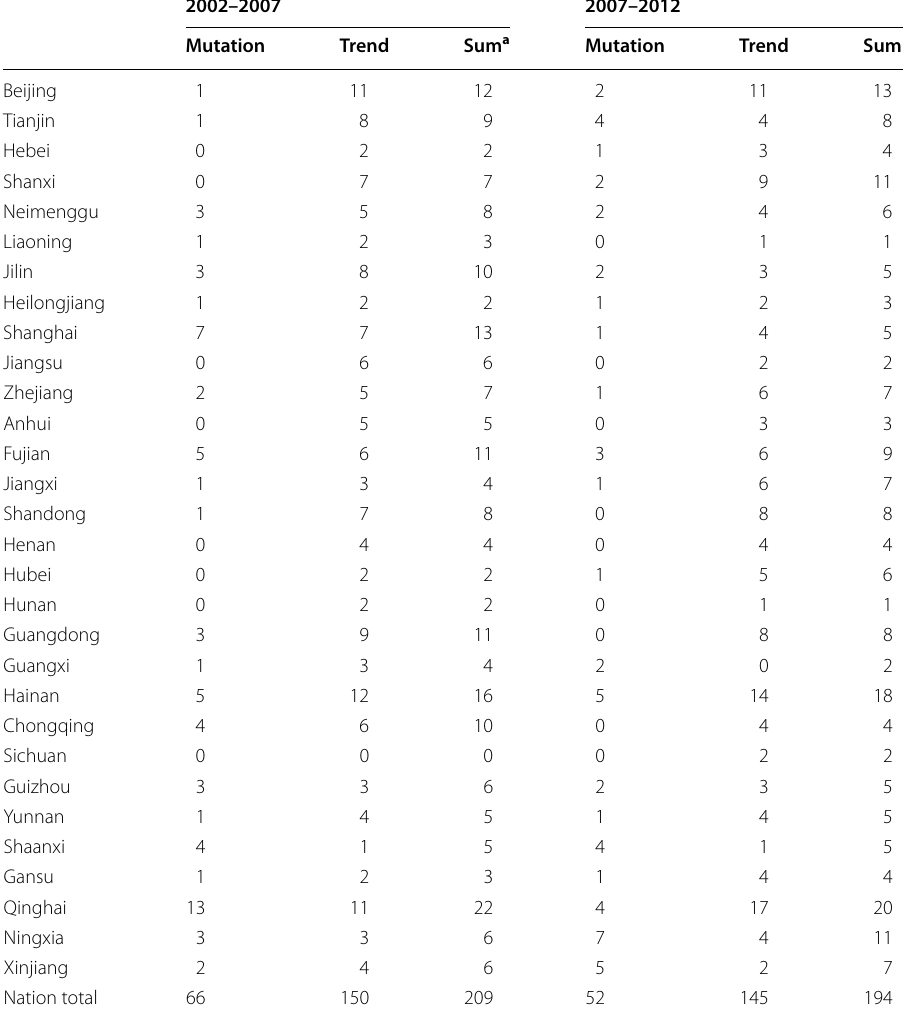
Table 11 Aberrant KC indicators summed by